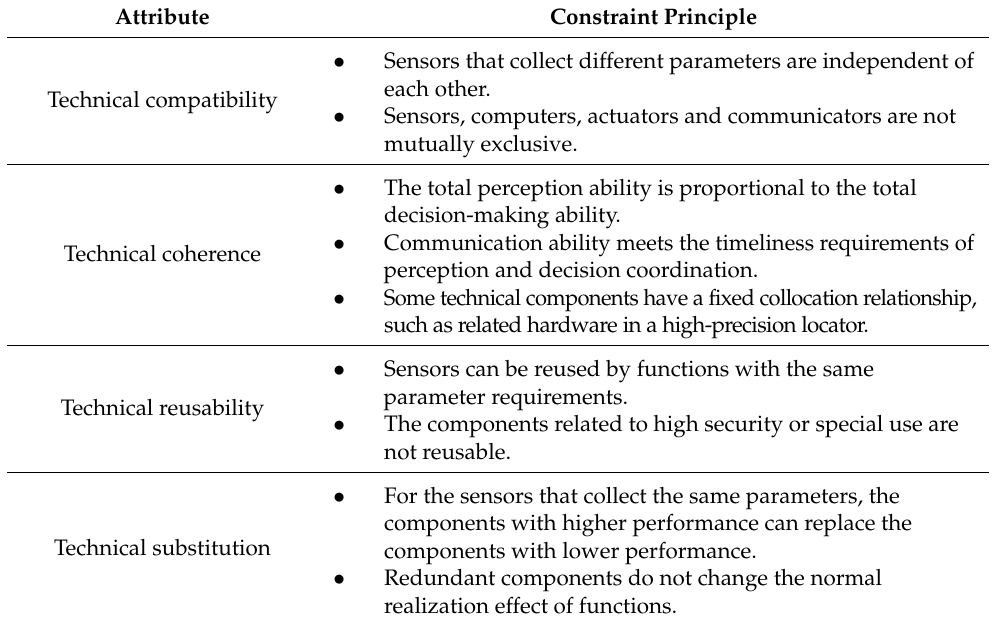
Table 2. Combination constraints of technical